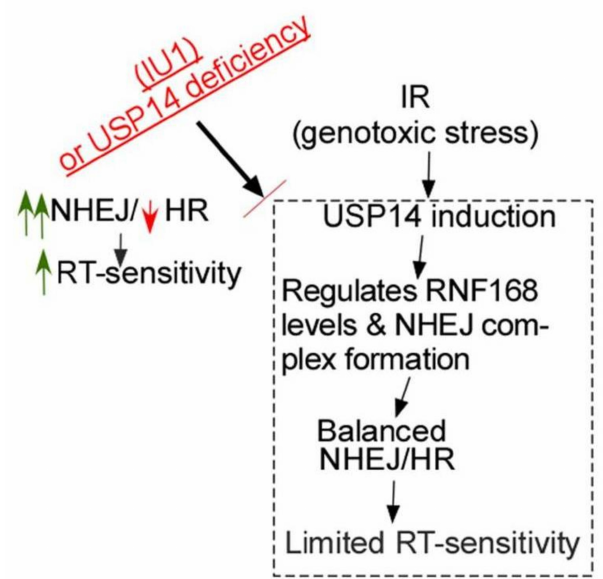
Figure 6. Model for the interface between USP14 and DDR in NSCLC. Genotoxic stress following IR treatment in NSCLC cells induces USP14 expression and its recruitment to DSB sites. USP14